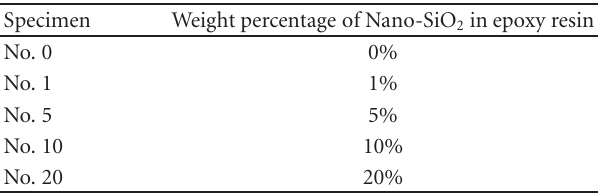
Table 1: Specimen